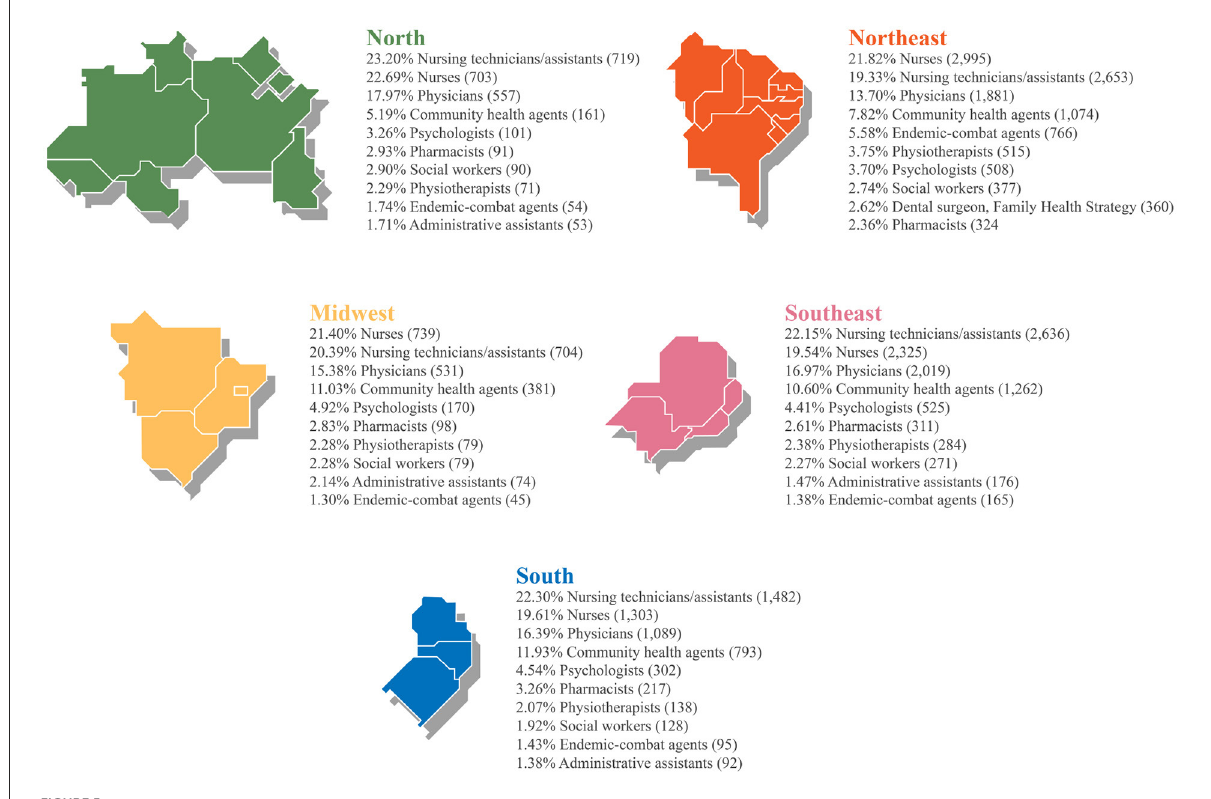
FIGURE5 Ranking of participants’ occupations by